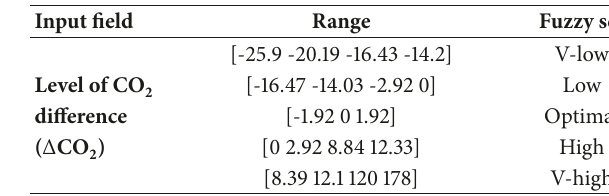
Table 6: MFs of CO 2 level difference ( Δ CO 2 ).